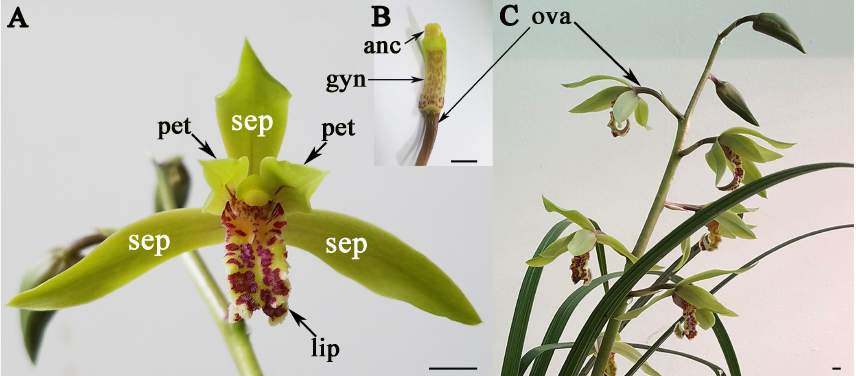
Figure 1. Flower and inflorescence of Cymbidium faberi. ( A ) Flower of C. faberi ; ( B ) The gynostemium and ovary of C. faberi ; ( C ) The inflorescence of C. faberi. Sepals (sep), petals (pet), lips (lip), anther cap (anc), gynostemium (gyn), ovary (ova). Bars: 5